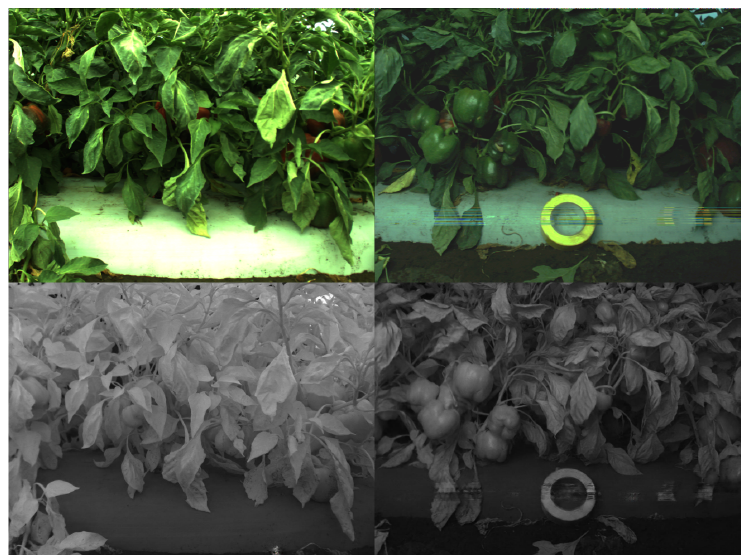
Figure 17. Synthetic NIR generation of capsicum dataset. Each row shows RGB and the corresponding NIR. Interestingly, capsicum detection performance decreased 0.01 mAP increased 0.01 mAP . This suggests that synthetic NIR contributed to inaccurately detect instances [0.5] IoU < 0.5 which can be hidden capsicums under shadow. However, these are rejected in evaluating the more strict metric, mAP [0.5:0.95]